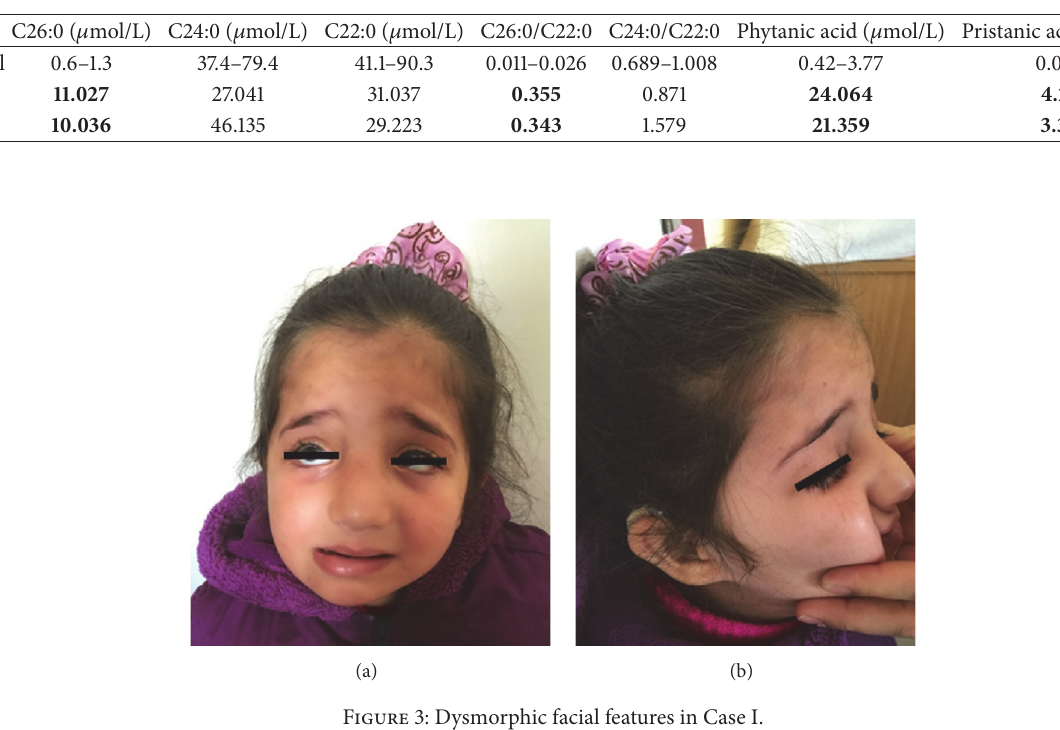
Table 1: Very long chain fatty acid analysis in two patients.